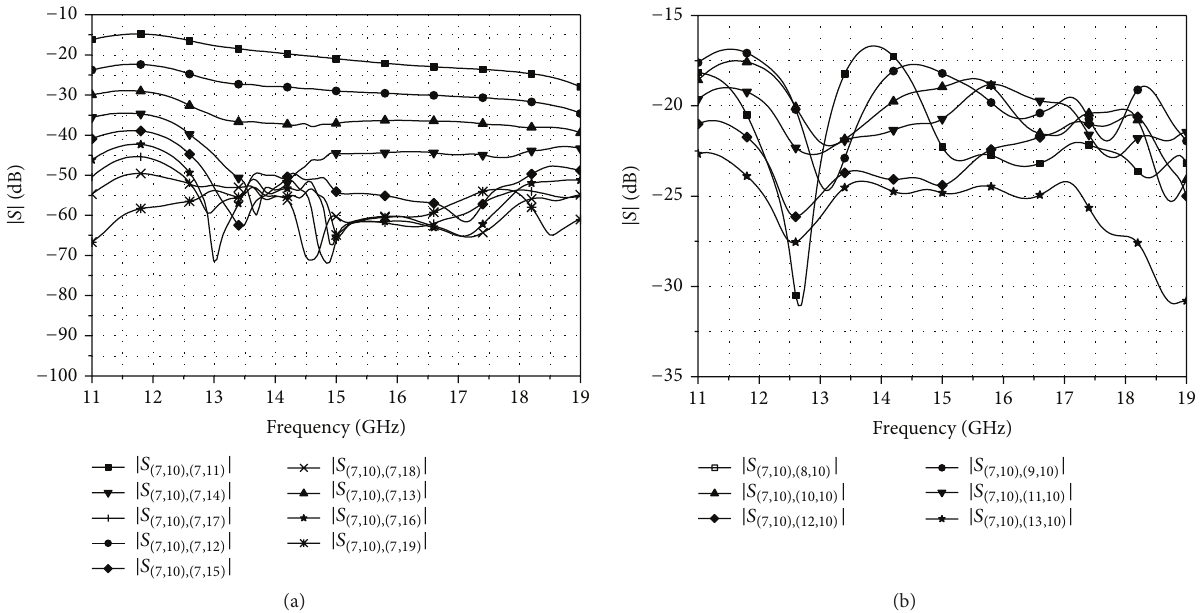
Figure 3: Mutual couplings between two separated elements. (a) Seventh single-row array. (b) Tenth single-column array.